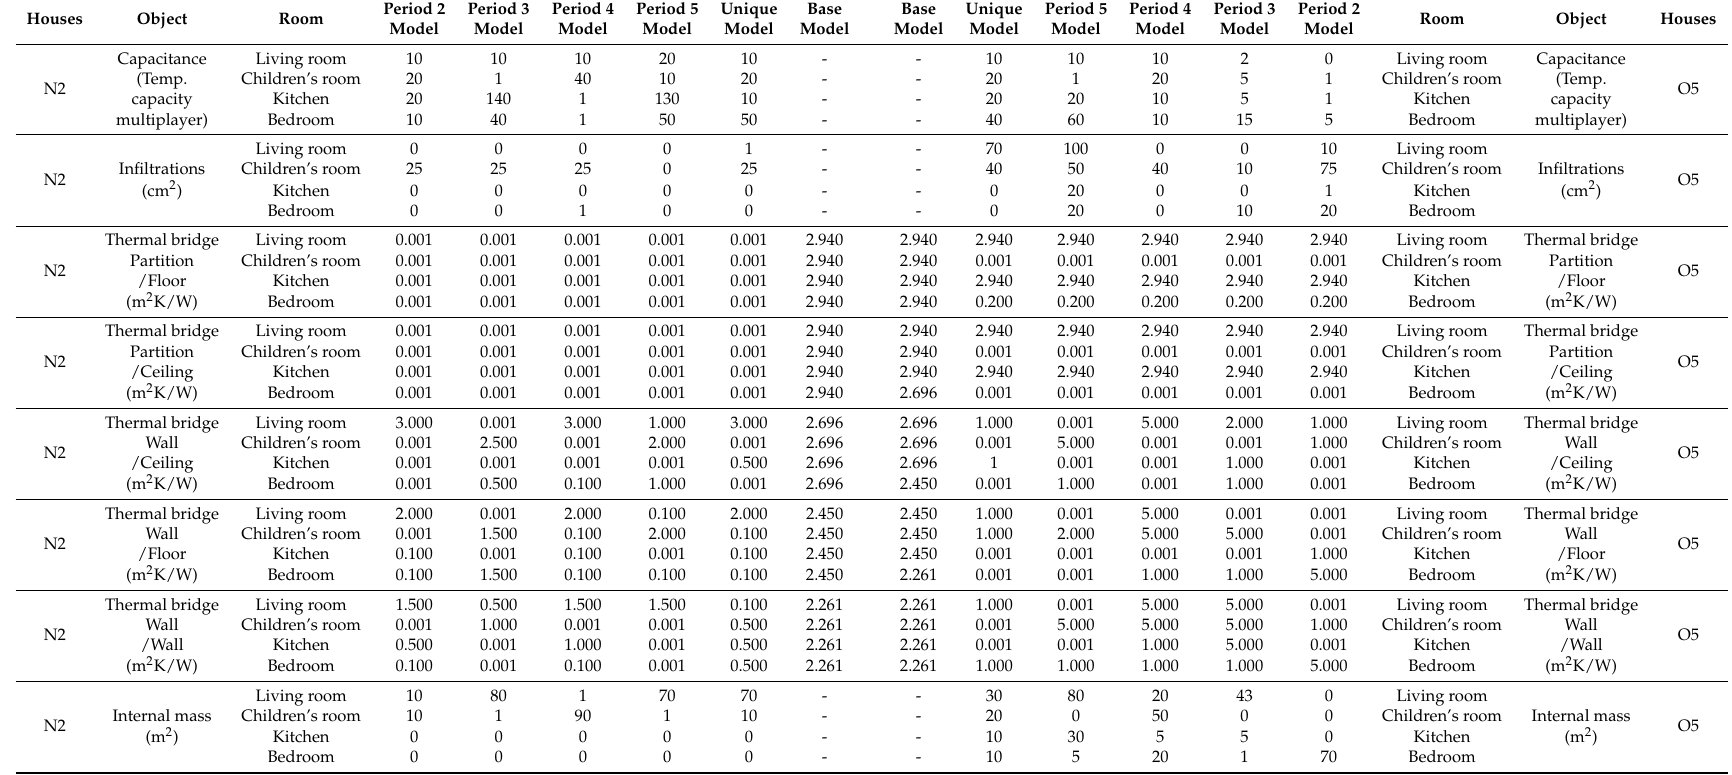
Table 7. Parameters selected in the calibration process for each energy